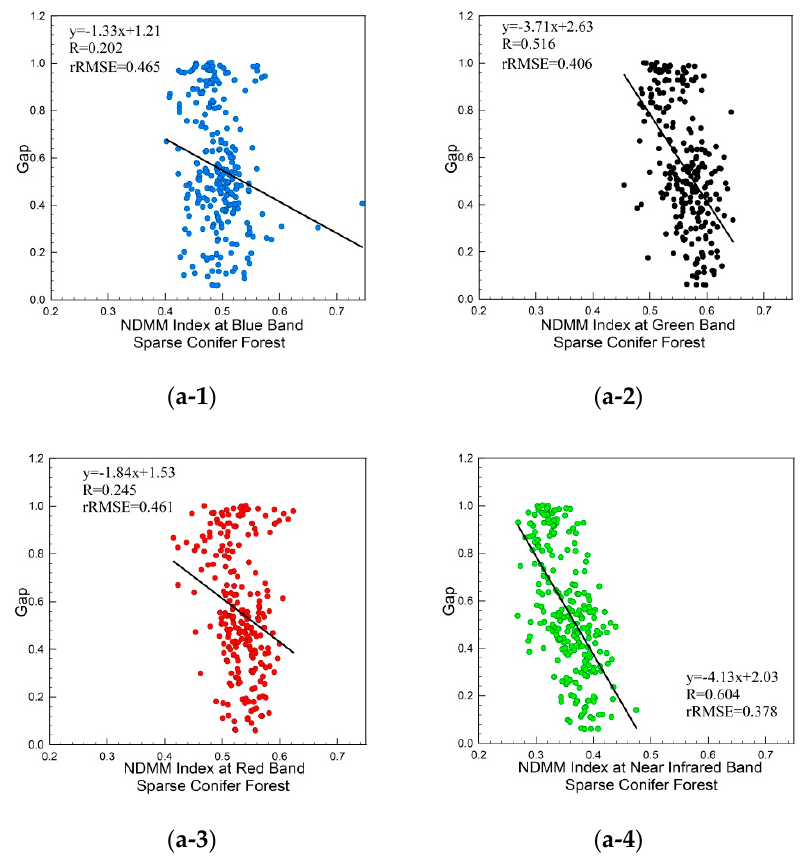
Figure 11. Relationship between the gap fraction and NDMM index at four bands for sparse confer forests in Howland. ( a-1 ), ( a-2 ), ( a-3 ) and ( a-4 ) represent the relationship between the gap fraction and NDMM Index at blue, green, red and near-infrared band for the sparse conifer forests respectively.